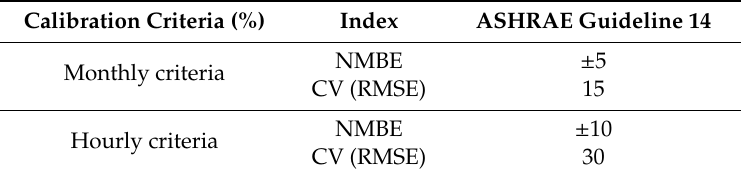
Table 1. The calibration criteria proposed by ASHRAE Guideline 14